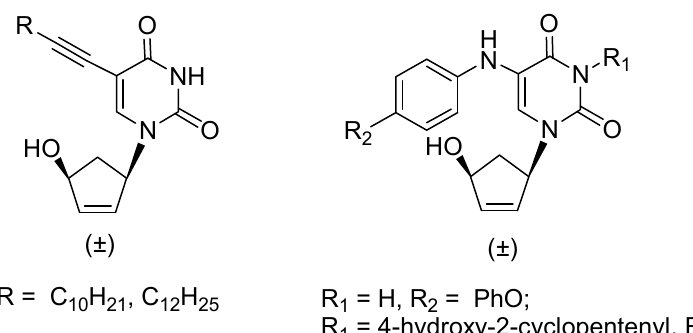
Figure 2. Examples of anti-Mtb 5 ′ -norcarbocyclic nucleosides.